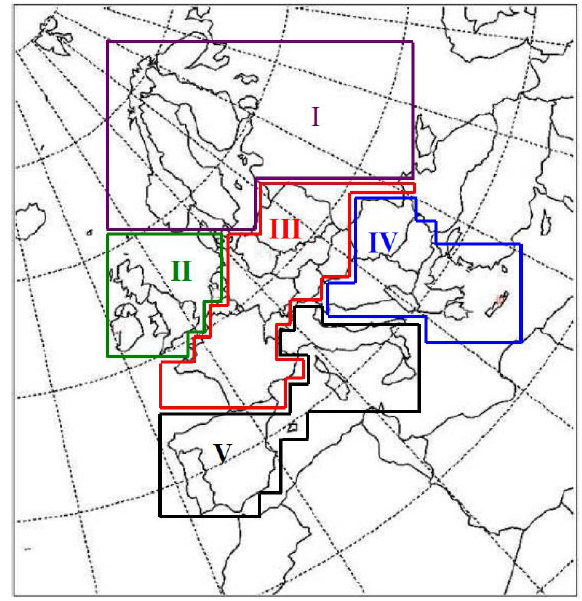
Fig. 1. Modeling domain of PMCAMx-2008 for Europe. The lo- cation of the five regions used for the investigation of the spatial Figure 1. Modeling domain of PMCAMx-2008 for Europe. The location of the five regions 3 dependence of the PM 2 . 5 responses to emissions and temperature used for the investigation of the spatial dependence of the PM 2.5 responses to emissions and 4 changes are also shown (I = North Europe, II = UK and Western Europe, III = Central Europe, IV = Balkans, V = Southwest Eu- temperature changes are also shown (I = North Europe, II = UK and Western Europe, III = 5 Central Europe, IV = Balkans, V = Southwest Europe). 6